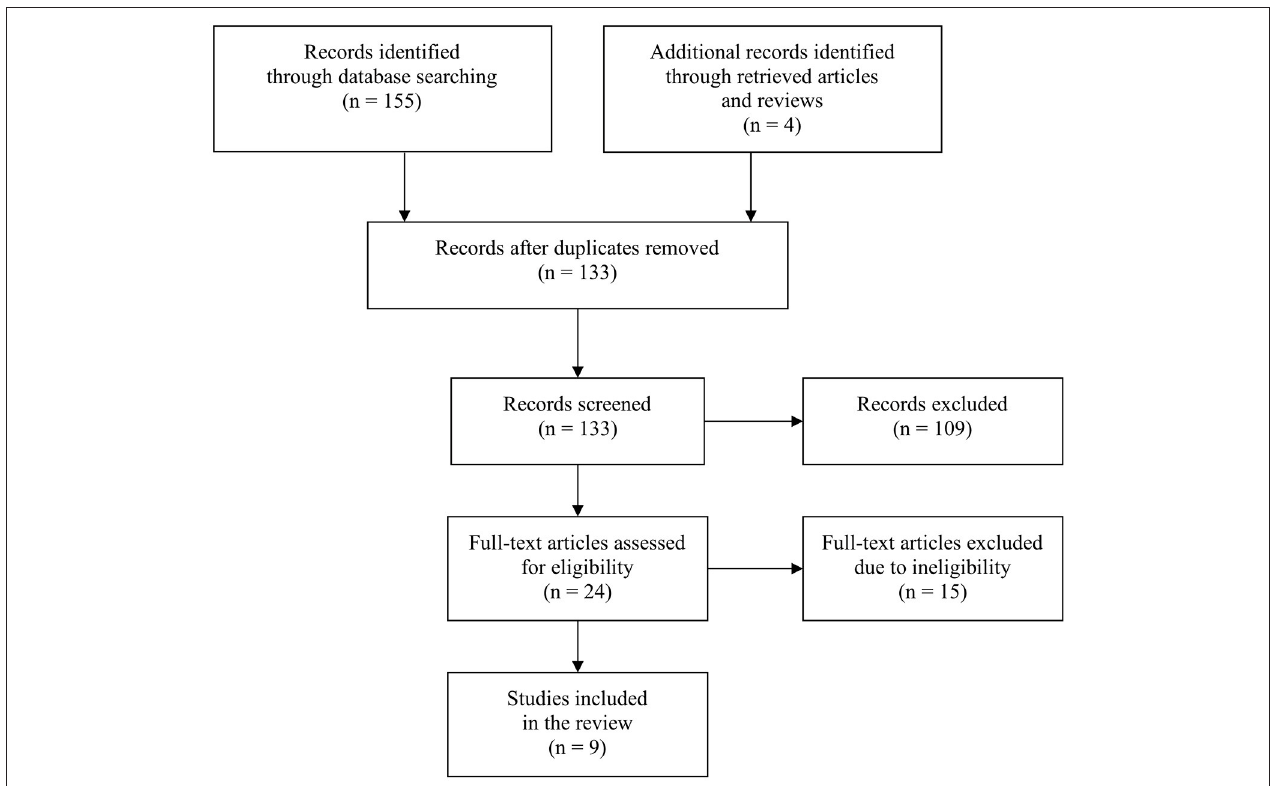
FIGURE 1 | PRISMA flowchart of database search